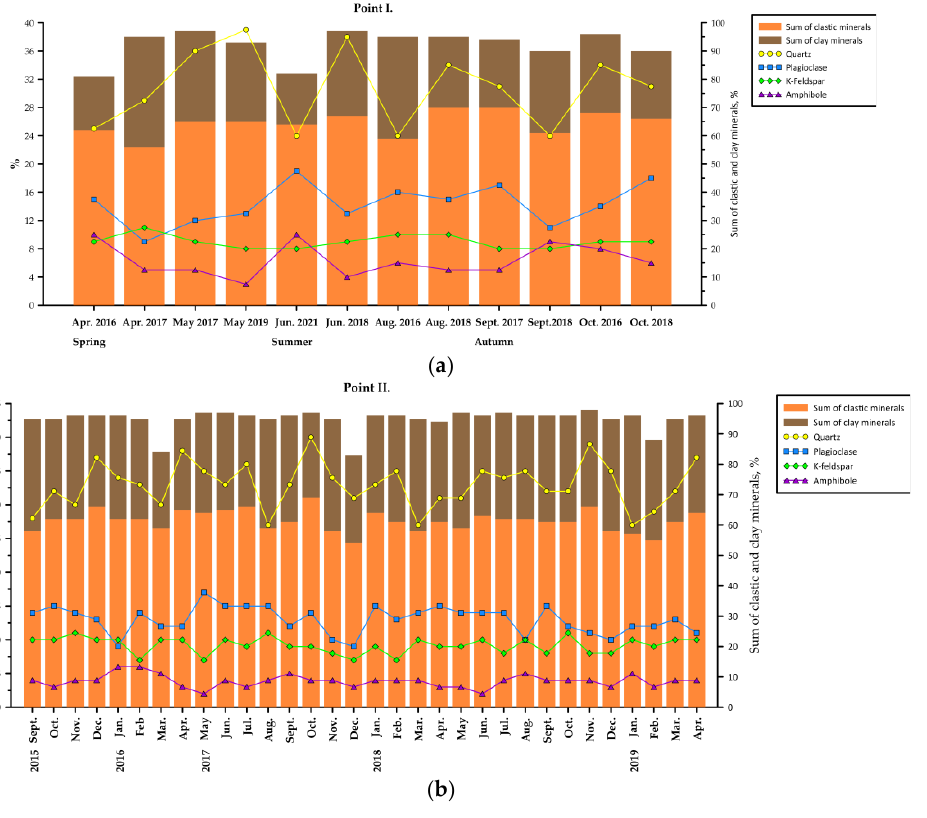
Figure 3. ( a ) Variations of the sum of clastic minerals and the sum of clay minerals and of the main clastic minerals for sampling point I. ( b ) The same as ( a ) but for sampling point